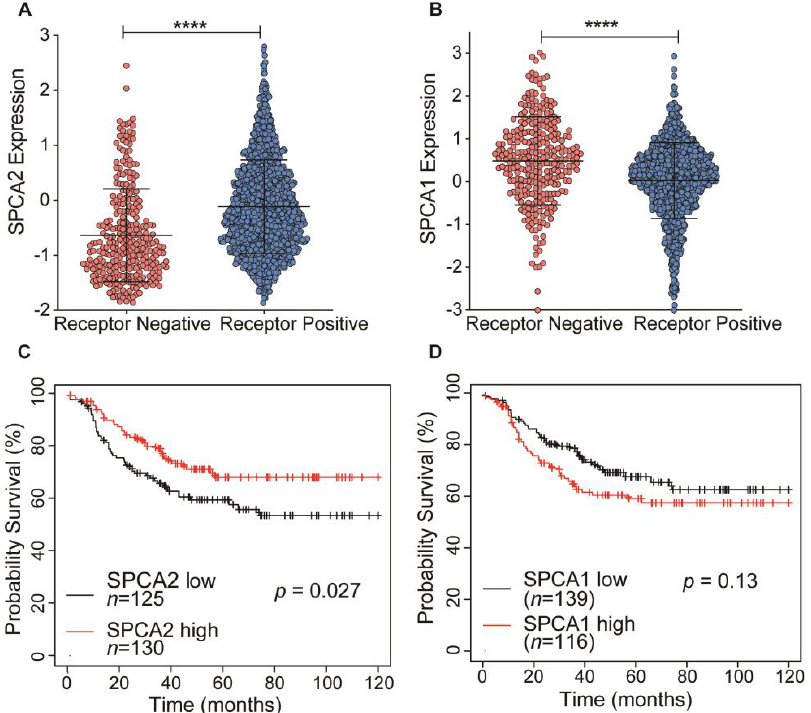
Figure 1. Isoform-specific expression and survival prognosis of SPCA genes in triple receptor negative breast cancer (TNBC). ( A , B ) Expression of ( A ) SPCA2 and ( B ) SPCA1 was analyzed in receptor positive and negative (TNBC) breast cancers from TCGA database; n = 290 for receptor-negative patients and n = 1222 for receptor-positive patients. ( C , D ) Kaplan–Meier analysis of regression-free survival in patients stratified by ( C ) SPCA2 or ( D ) SPCA1 expression level. Data from KMplotter selected ER, PR, and HER2 (negative). Hazard ratio = 0.62 (0.4–0.95); Logrank test, n = 125 in low SPCA2 group, and n = 130 in high SPCA2 group. Hazard ratio= 1.38 (0.91–2.11), Logrank test, n = 139 in low SPCA1 group and n = 116 in high SPCA1 group. **** p <